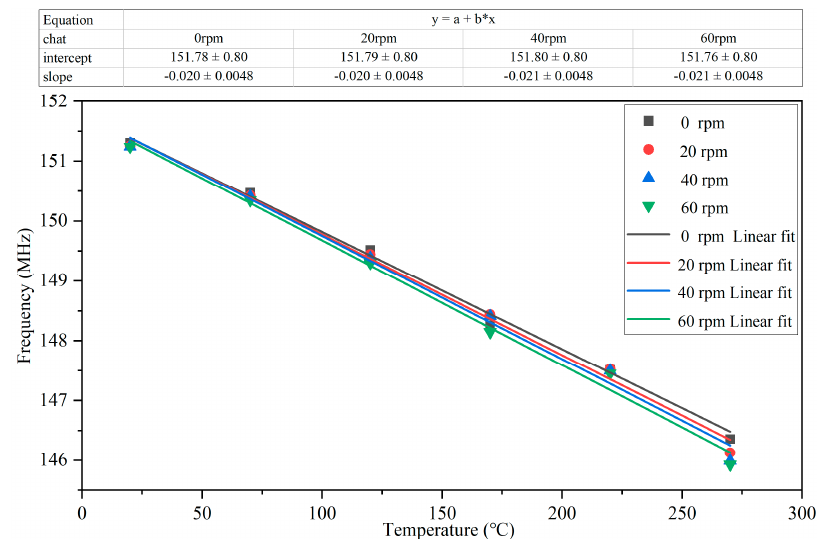
Figure 9. Comparison of the nonlinear error ( e n ) values for five sets of speed measurements at different rotational